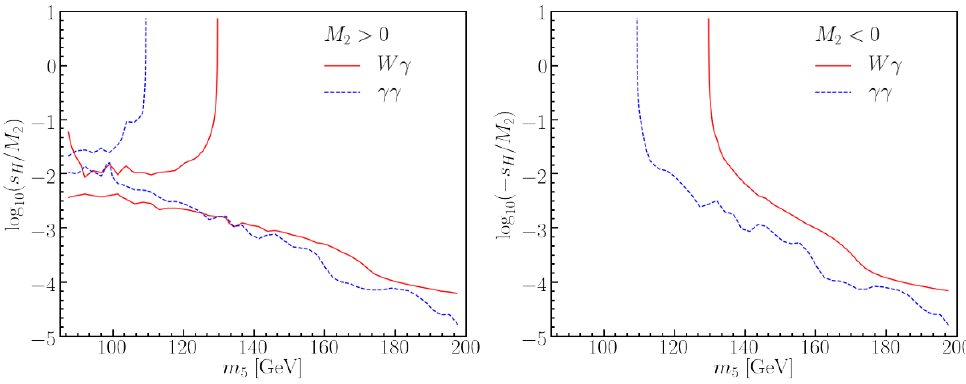
Figure 11 . The projected 95% CL exclusion reach for the W(cid:13) channel (red solid line) valid for s H . 0 : 3 and m 5 > 100 GeV. The region to the left of the curve can be excluded with 300 fb (cid:0) 1 of data at the 14 TeV LHC. Contours are shown as a function of m 5 and s H =M 2 (in GeV (cid:0) 1 ) for positive (left) and negative (right) M 2 . The region to the left of the blue dashed line is already excluded in the GM model by LHC diphoton resonance searches via the process pp H 0 (cid:13)(cid:13) (see section 5 !